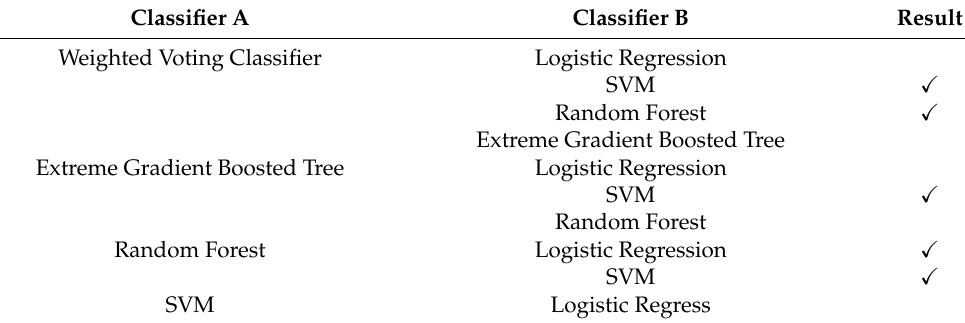
Table 4. 5x2cv paired t